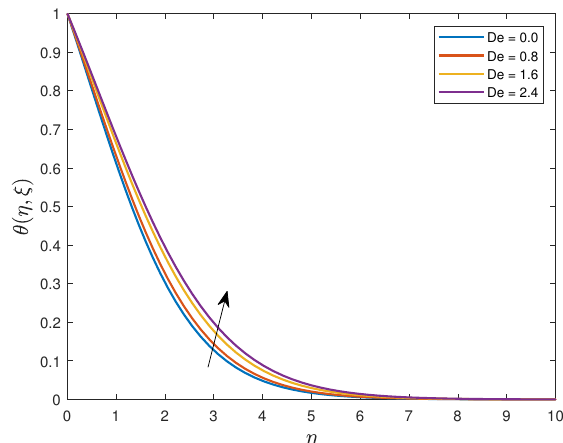
Figure 13. The influence of De on fluid velocity.